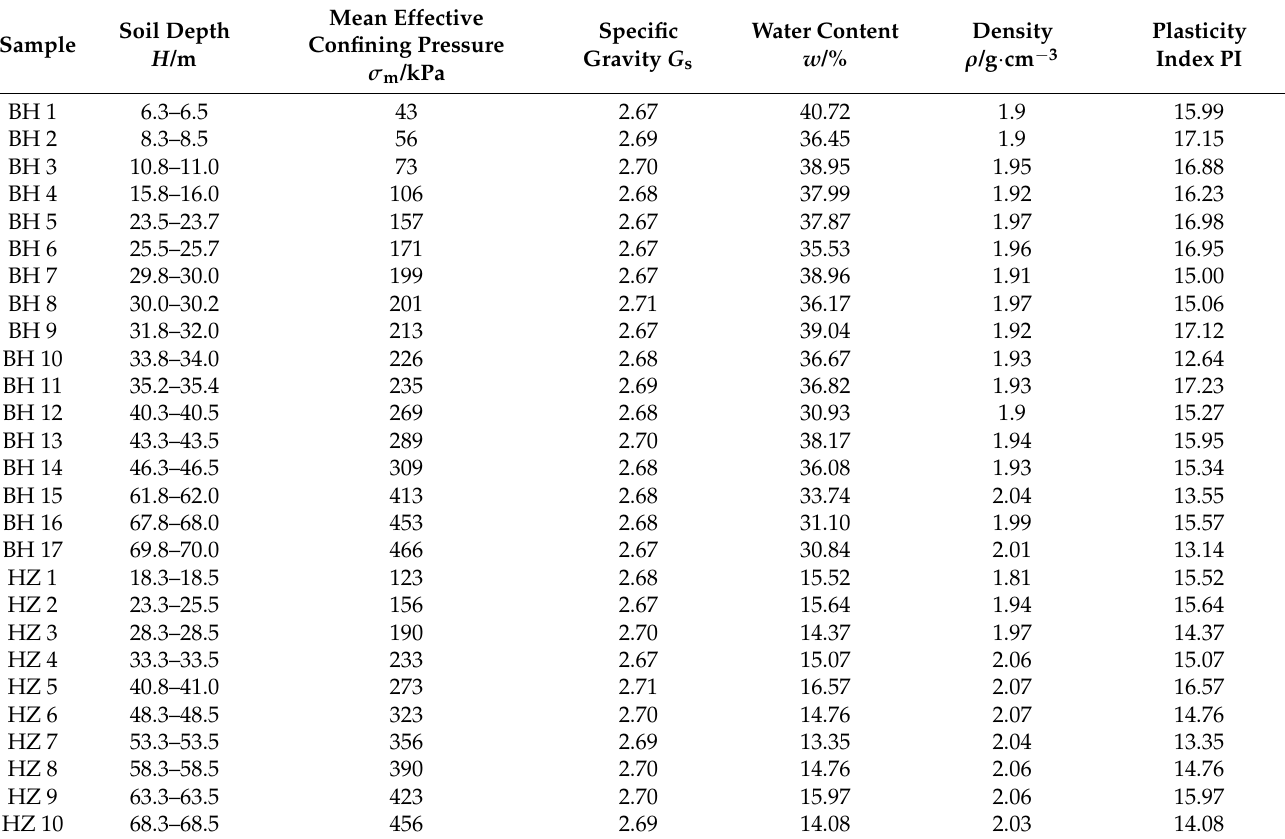
Table 2. Representative physical parameters of the marine clays.